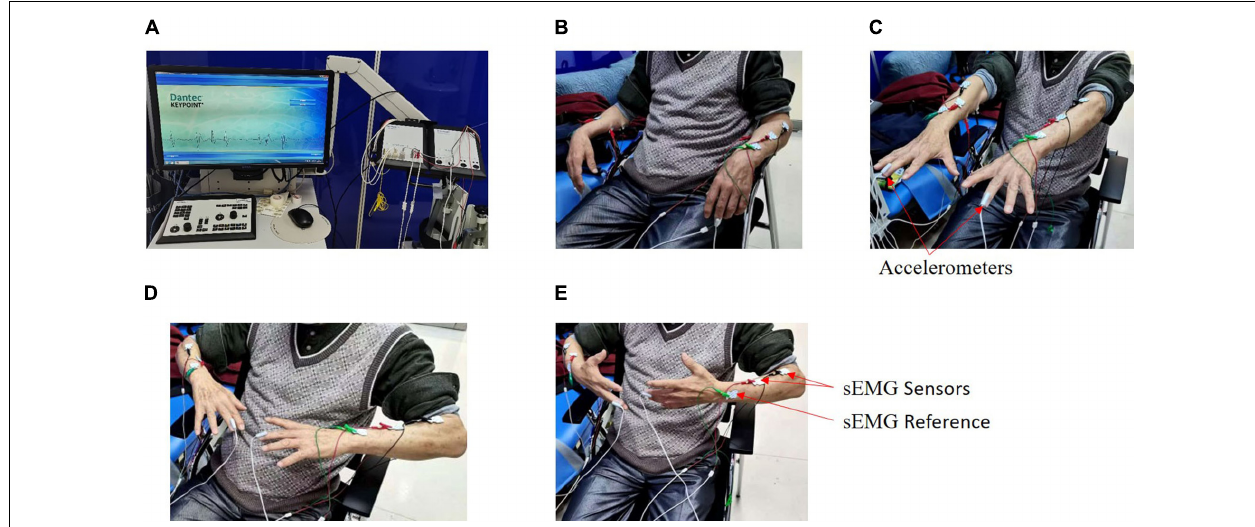
FIGURE 1 | Experimental setup. Tremor information was collected from four postures by a medical device system called Dantec R (cid:13) Keypoint R (cid:13) G4 for each patient. (A) Dantec R (cid:13) Keypoint R (cid:13) G4. (B) Resting posture. (C) Stretching posture. (D) Winging posture. (E) Vertically winging posture.